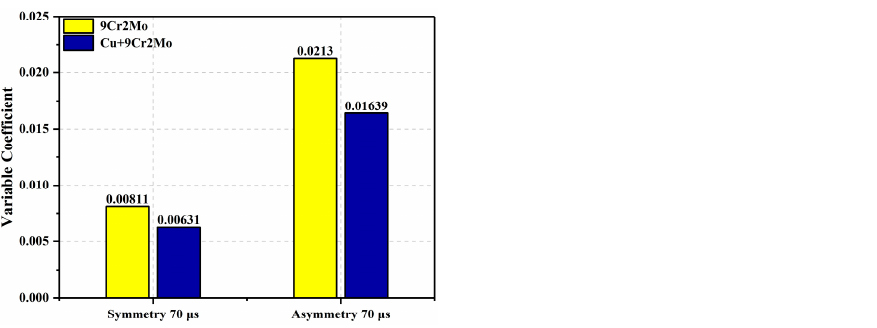
Figure 5. The J e / J ave distribution of tensile device with wrap angle: ( a ) 9Cr2Mo–asymmetry–5.0 A/mm 2 ; and ( b ) 9Cr2Mo–symmetry–5.0 A/mm 2 .